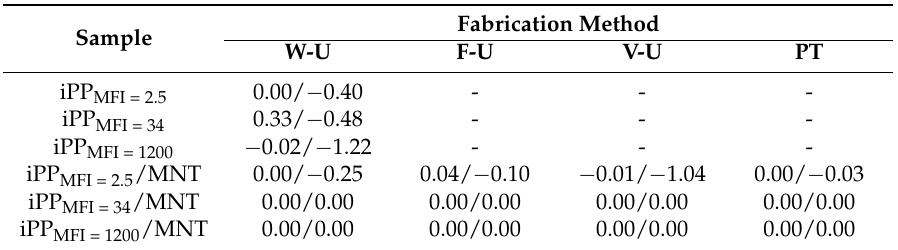
Table 5. Electric charge (kV) for iPP homopolymers, and iPP/MNT nanocomposites fabricated by different